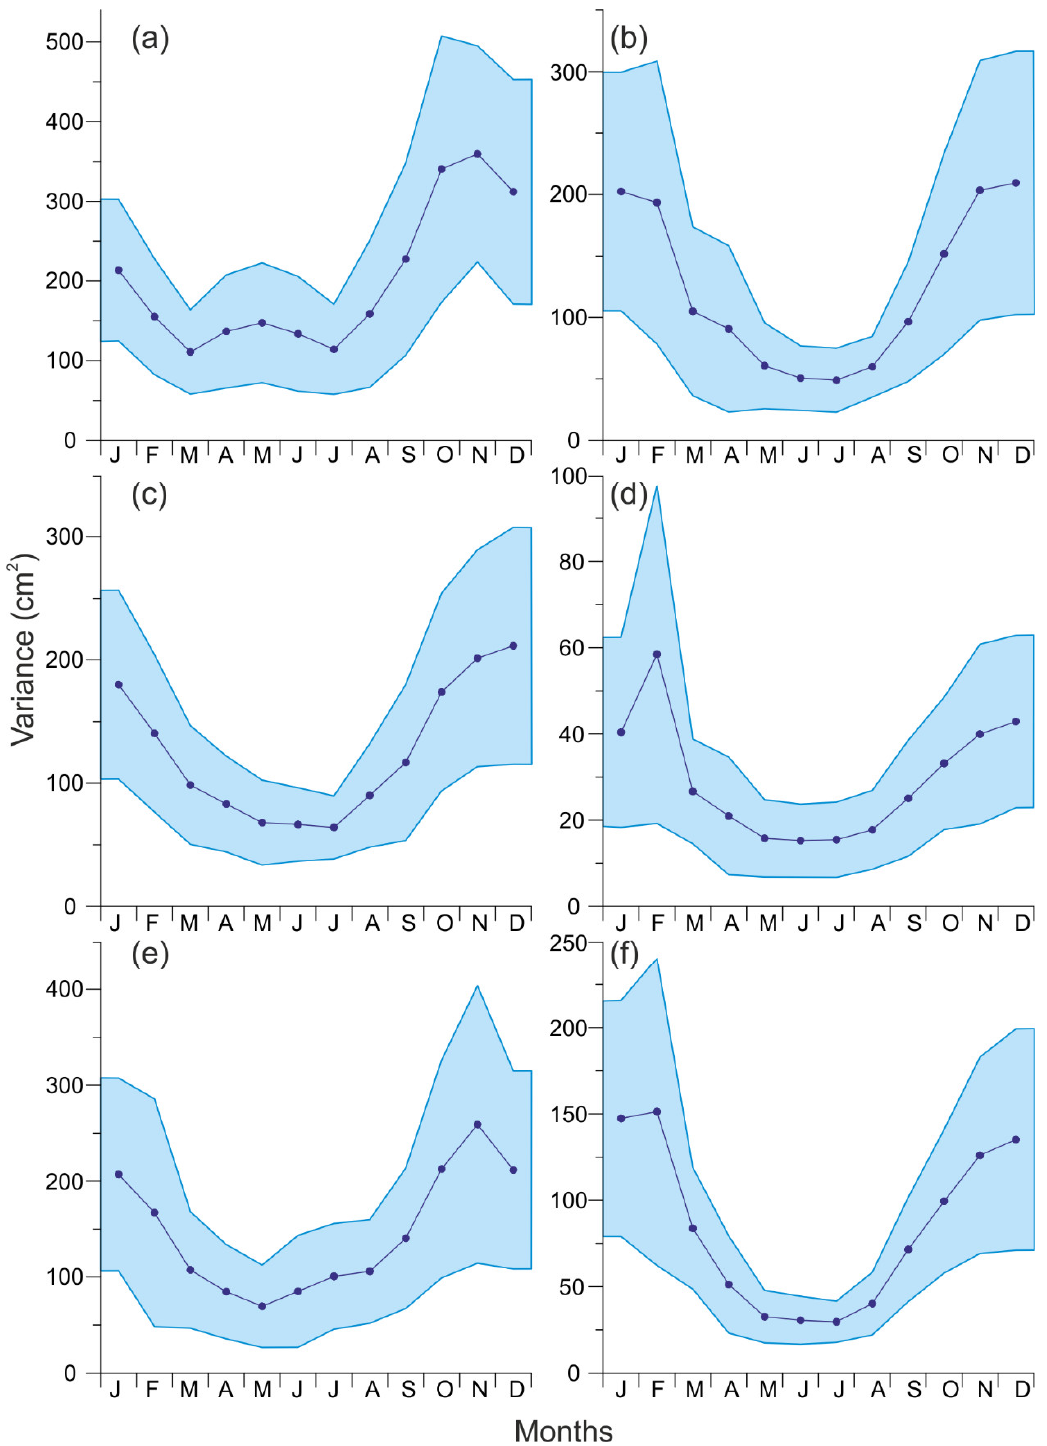
Figure 3. Seasonal changes of the variance of synoptic oscillations ( σ 2 syn ) for stations at ( a ) the Gorny Institute, ( b ) Ratan, ( c ) Narva, ( d ) Stockholm, ( e ) Pärnu, and ( f ) Kungsholmsfort. The light blue color is ± standard deviations of interannual changes of σ 2 syn , blue vectors are trends of its value: up is positive, down is negative, right is no